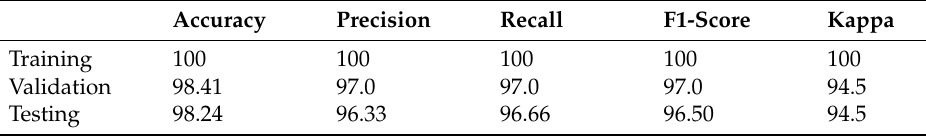
Table 8. Detailed results obtained with train, validate, and test